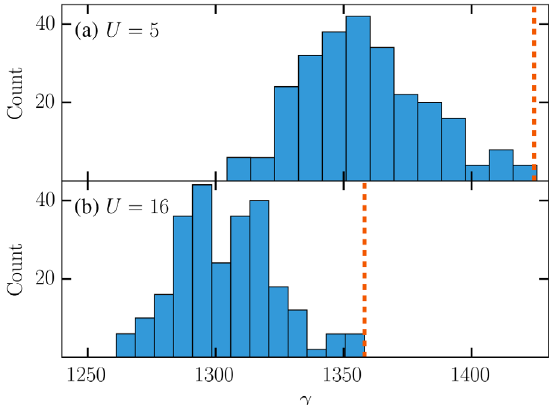
FIG. 8. Histogram of the overlap between the learned features and all the possible ordering patterns picked up by the 2 × 2 × 2 receptive cube. Top and bottom panels correspond to cases with U ¼ 5 and U ¼ 16 , respectively. The vertical dashed (red) line marks the value for the perfect AFM ordering